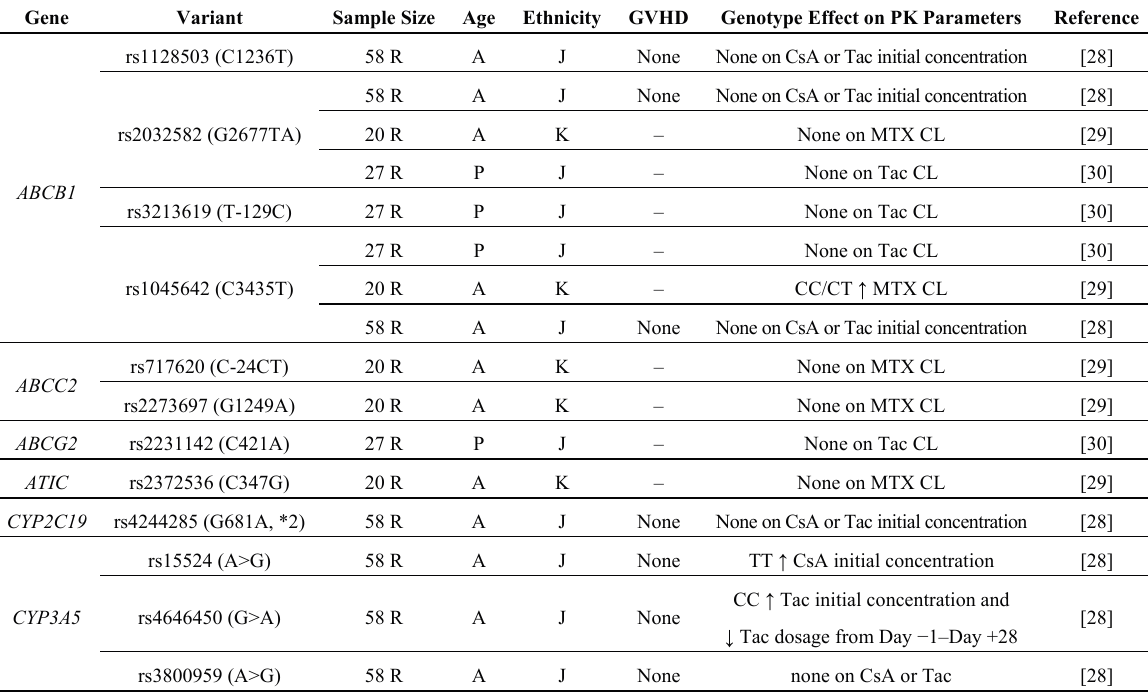
Table 1. Genetic association studies with graft vs. host disease (GVHD) and pharmacokinetic parameters in hematopoietic stem cell transplantation (HSCT)